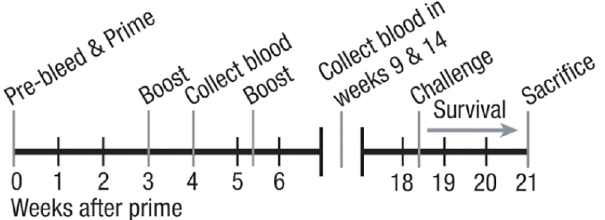
Fig 1. Mouse model of pneumococcal vaccination and infectious challenge. 2 – 3 month old mice were bled, and serum was collected prior to initial priming with Prevnar-13 on week 0. Mice were boosted on weeks 3 and 5 with the same vaccine. Mice were again bled on weeks 4, 9, and 14. Mice were then challenged with the virulent A66.1 strain of S . pneumoniae on week 18 and mortality was assessed for 16 days after